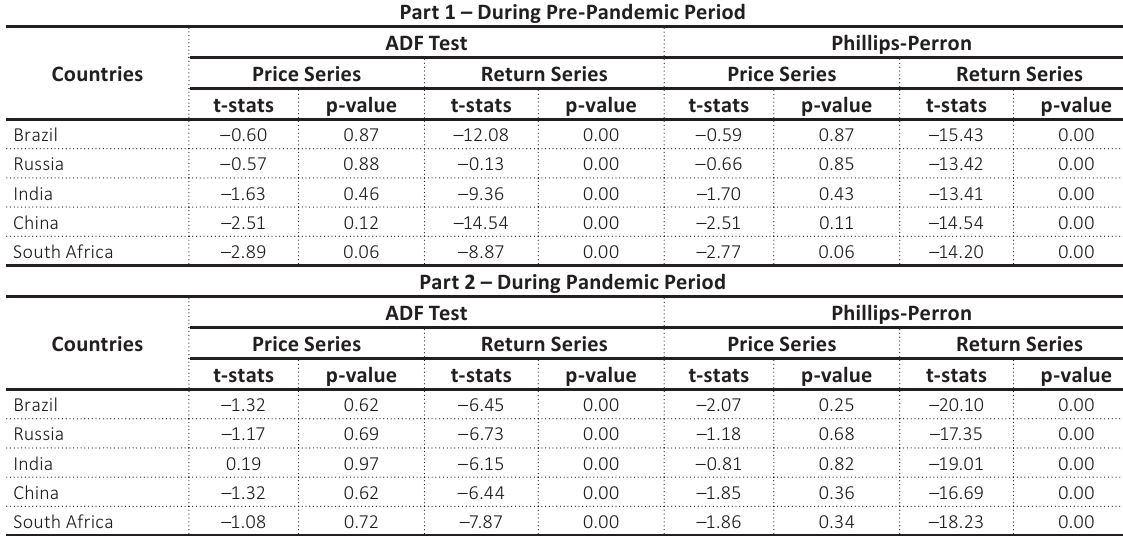
Table 3. Stationarity results